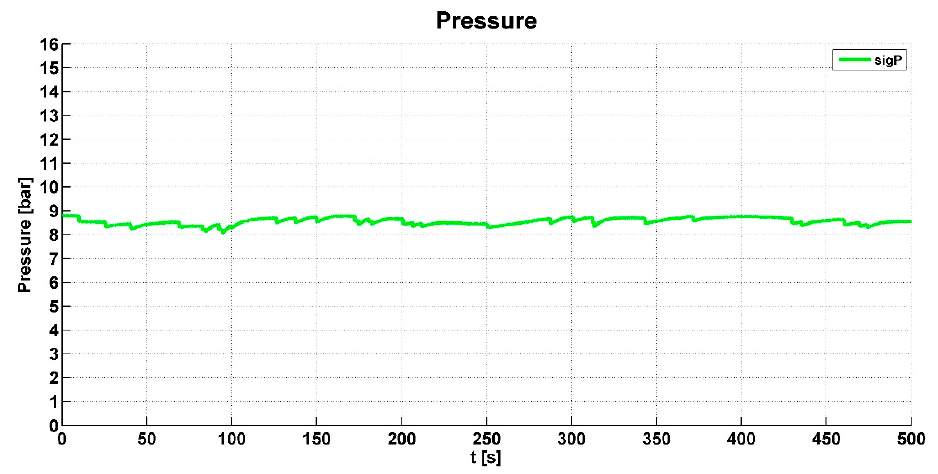
Figure 13. Air pressure value in the pneumatic circuit.